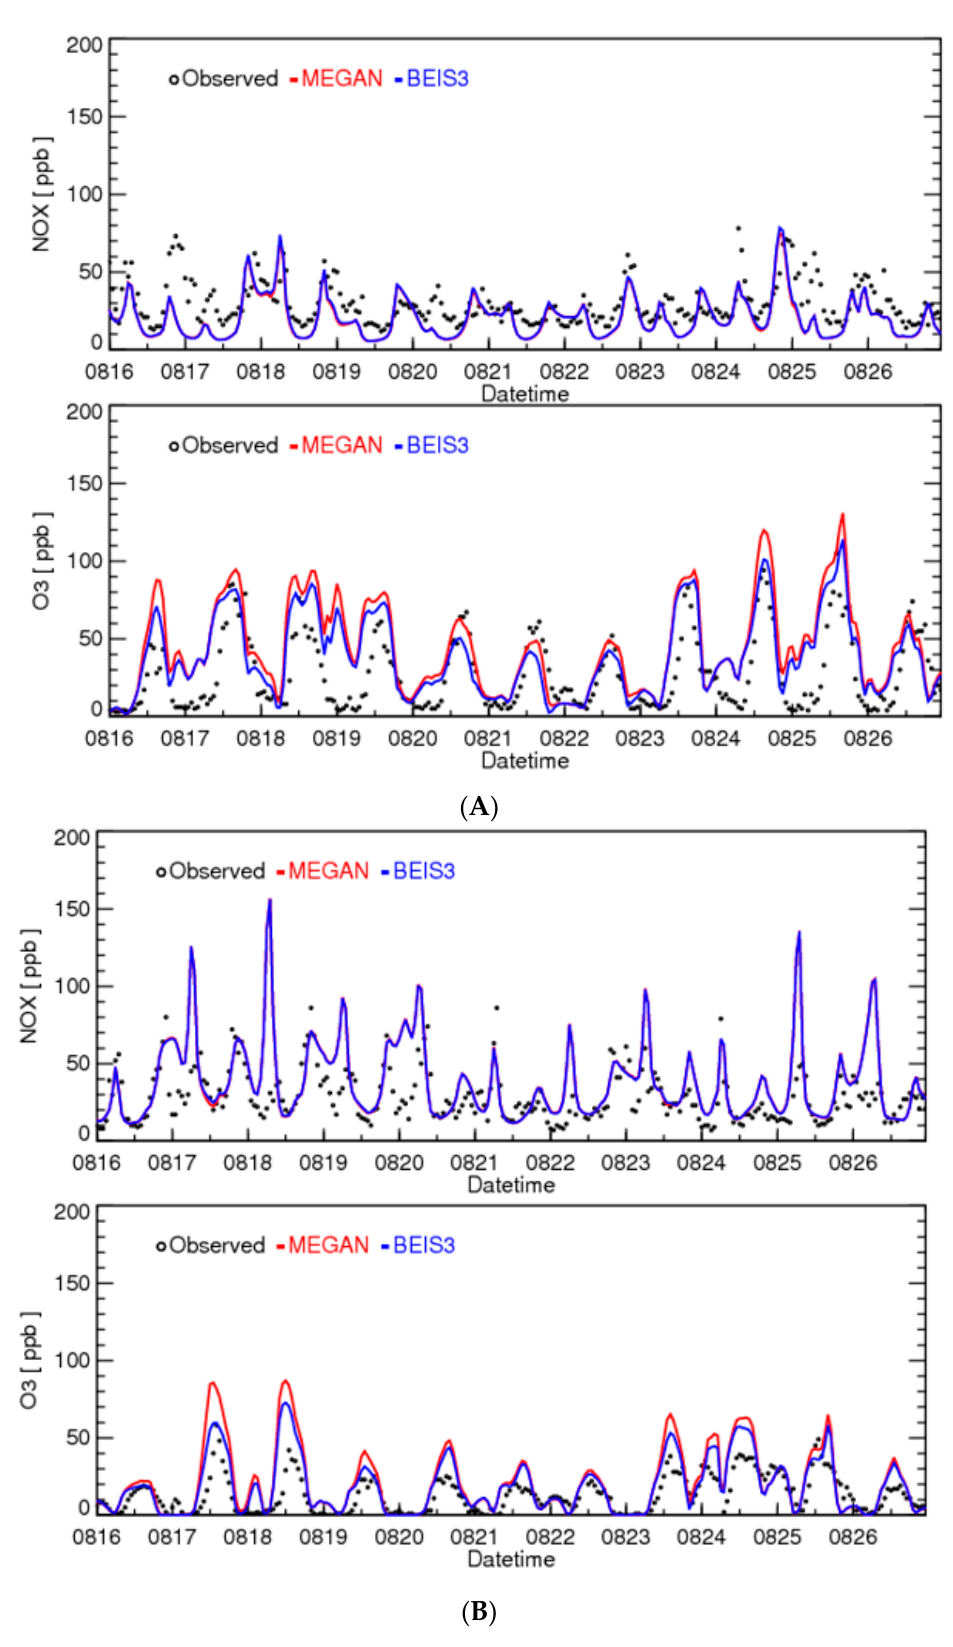
Figure 7. Modeled and observed NO x and O 3 concentrations at ( A ) a monitor near Busan and ( B ) another monitor in Gwangju where the model shows good or poor performance, respectively.